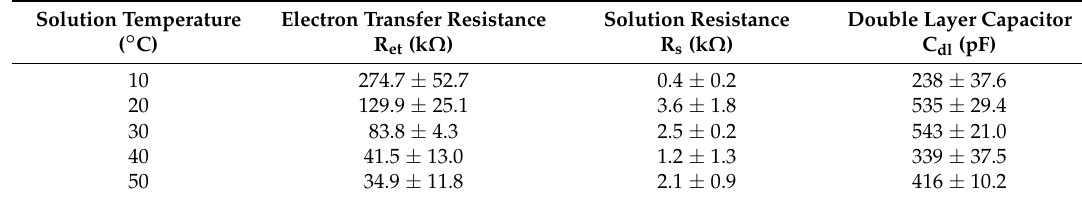
Figure 9. The electrochemical impedances of fitted curves in the different solution temperatures from 10 °C to 50 °C. Table 4. The fitted results of R et , R s and C dl in 1 M NaCl solution at the different solution temperatures.